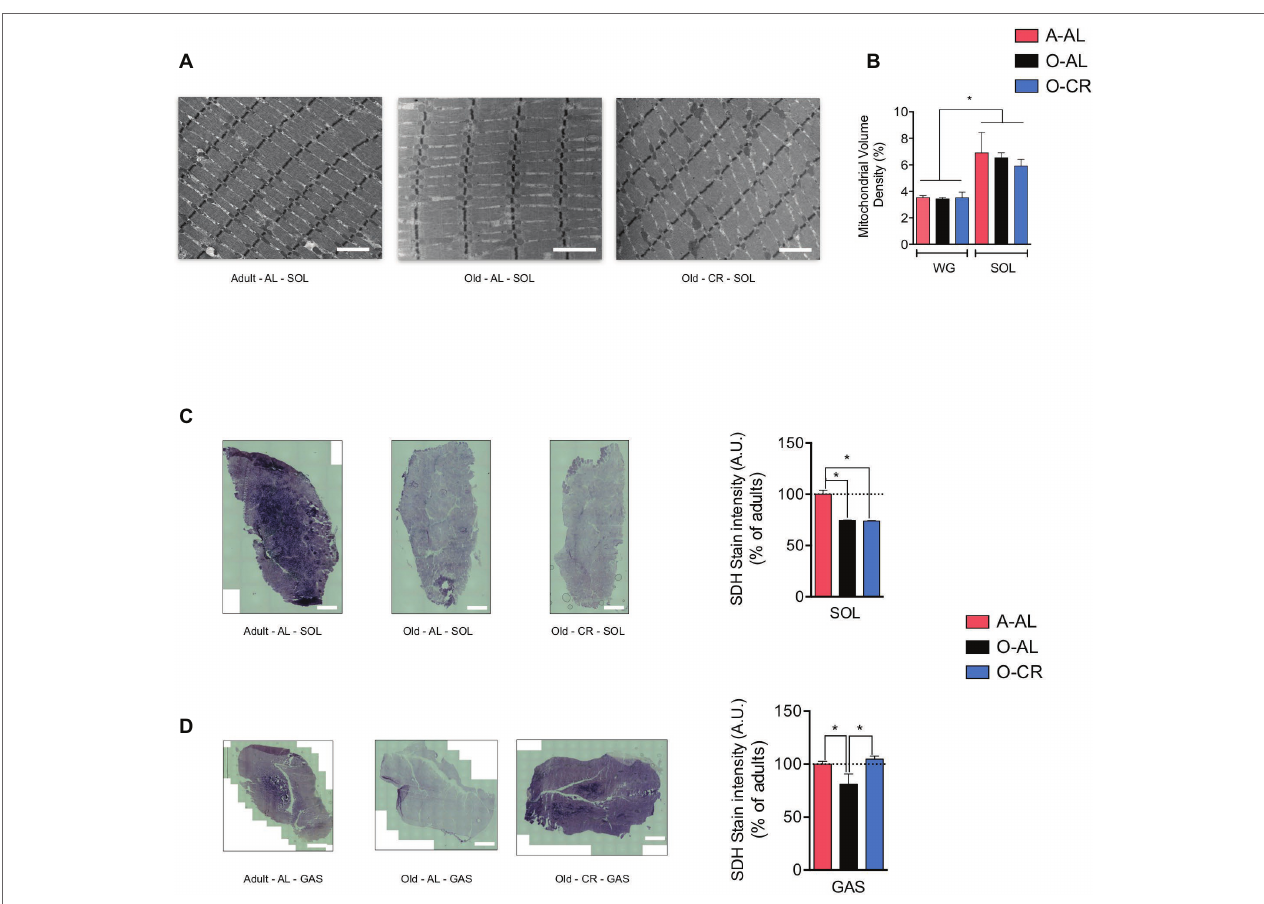
FIGURE 3 | Effect of aging on skeletal muscle mitochondrial content. (A) Representative longitudinal TEM images of A-AL, O-AL and O-CR that were used for the quantification of mitochondrial volume density. The results of these quantifications for the SOL and WG are presented in (B) (n = 4 in each group). (C) and (D) Representative succinate dehydrogenase (SDH) stain and quantification of SOL (C) and GAS (D) cross-sections of A-AL, O-AL and O-CR (A-AL, N = 7–8; O-AL, N = 4 and O-CR, N = 7–8). Data in graphs are presented as Mean ± SEM. Scale bars in (A) : 2 μm. Scale bars in (C) and (D) : 1000